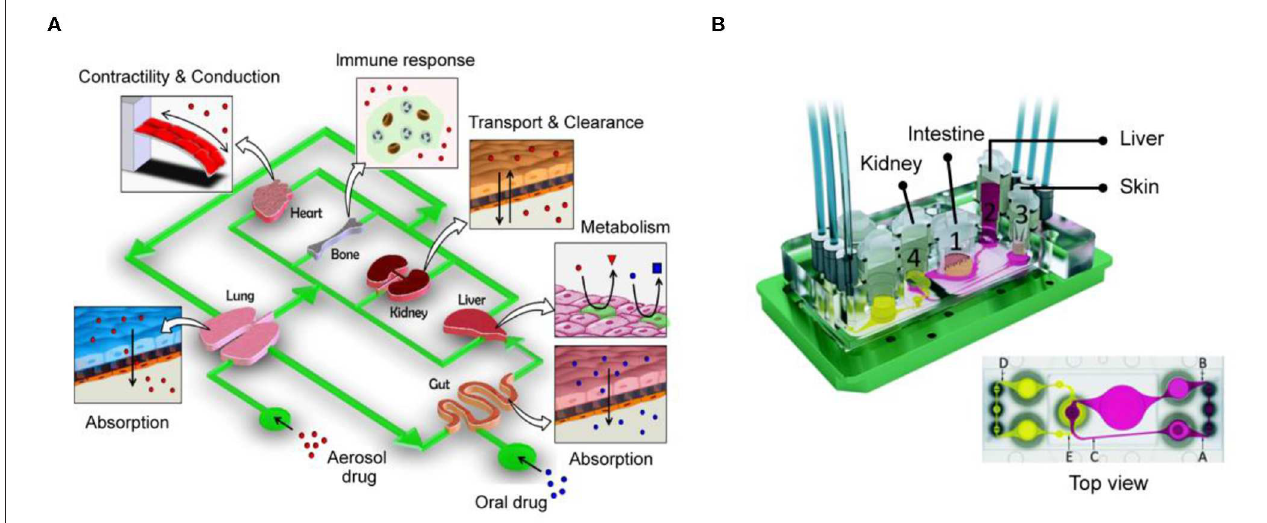
FIGURE 4 | Integrate multi-organ chip platforms to create complex interactions between human organs. (A) The design concept of the human body chip. One of the most promising in vitro system for replicating the systemic responses of human body. Reproduced with permission from Huh et al. (2011). (B) Four-organs-on-a-chip system employed intestine, liver, skin, and kidney tissue that proportionately simulated the physiological environment of the human body. Reproduced with permission from Maschmeyer et al.